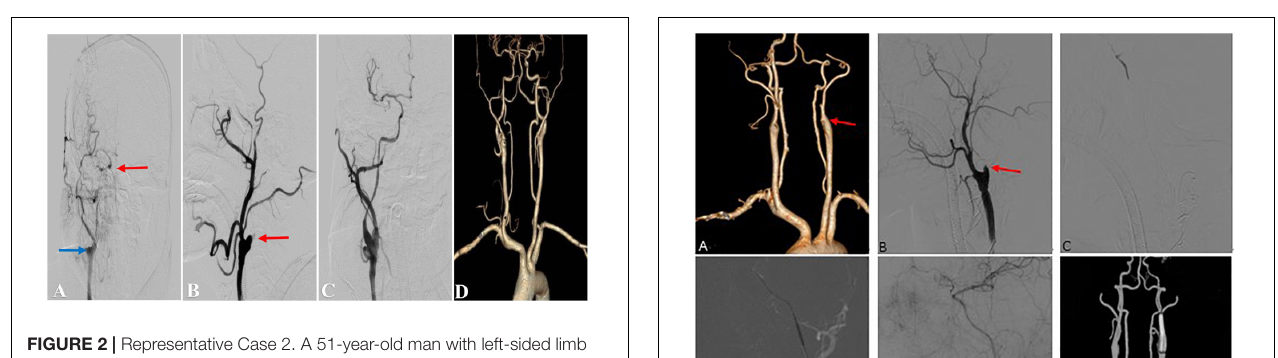
FIGURE 2 | Representative Case 2. A 51-year-old man with left-sided limb weakness underwent hybrid surgery for internal carotid artery occlusion (ICAO). (A) Preoperative angiography showed right ICA occlusion (blue arrow) with filling at the cavernous segment (red arrow). Intraoperative angiography showed (B) an artificial stump after carotid endarterectomy (red arrow) and (C) successful recanalization after deployment of the stent. (D) Computed tomography angiography showed a patent ICA at 3 months after the surgery.